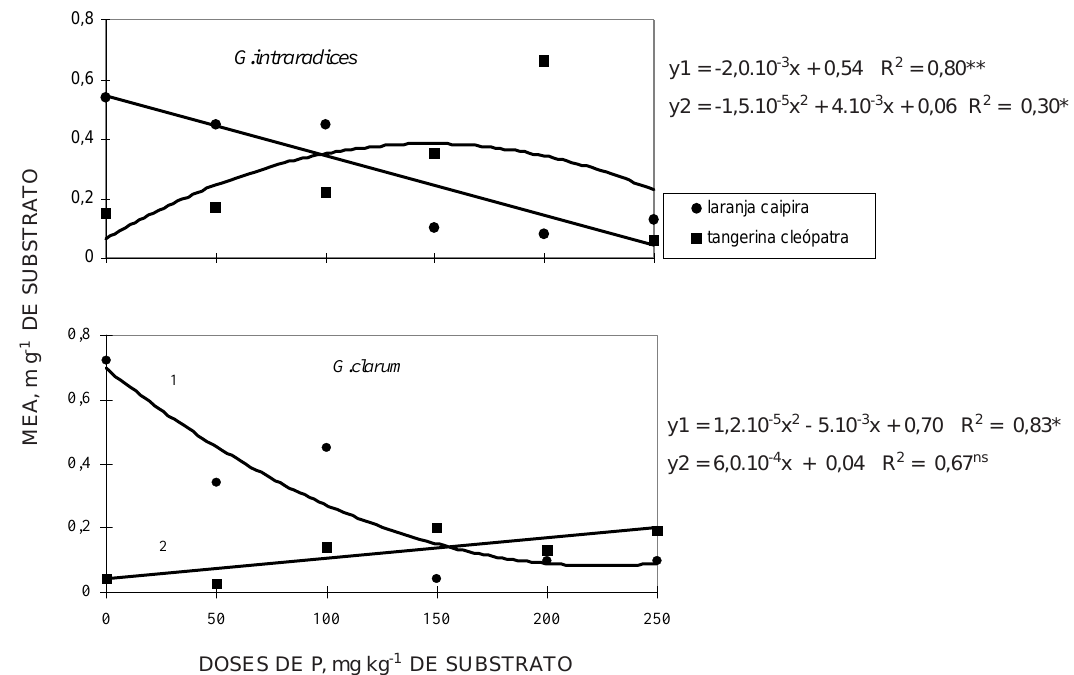
Figura 2. Comprimento de micélio extrarradicular ativo (MEA) de G. intraradices e G. clarum , nos porta- enxertos laranja caipira e tangerina cleópatra, considerando as doses aplicadas de P e métodos FDA e INT (média de 10